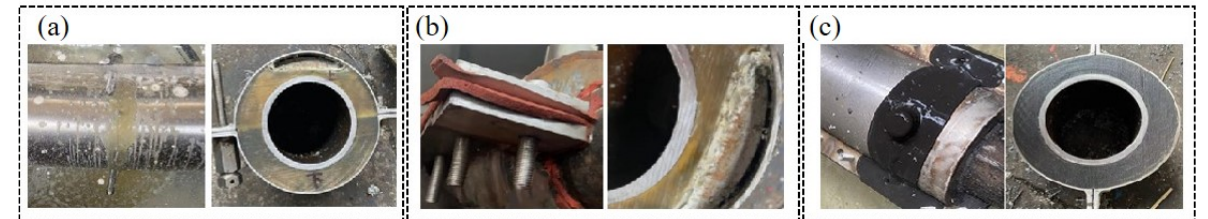
Figure 7. Plugging agent dispensing test: ( a ) the plugging agent leaking and not being in a fully filled state after curing; ( b ) the improved sleeve closure and plugging agent micro-crack state; and ( c ) the plugging agent curing success state.